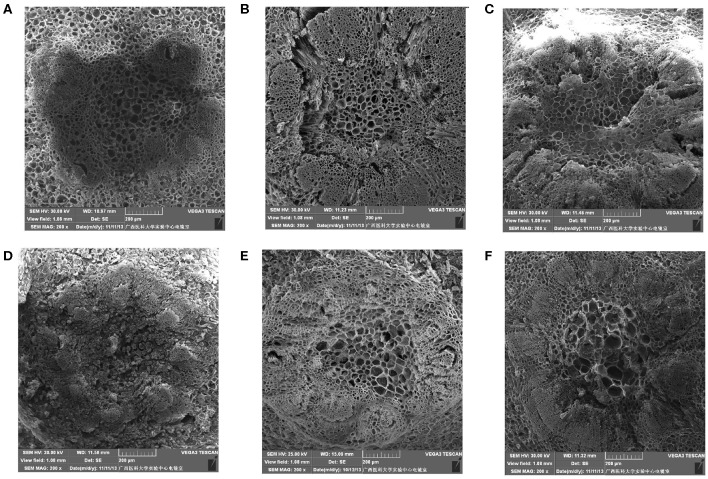
The ultrastructure of fruit pedicel cells of table grapes in storage for 0 or 6 days (×200). After storage for 0 day in “Muscat Kyoho” (A), “Kyoho” (B), and “Nanyu” (C); after storage for 6 days in “Muscat Kyoho,” (D), “Kyoho,” (E), and “Nanyu” (F). All images are of vertical sections.